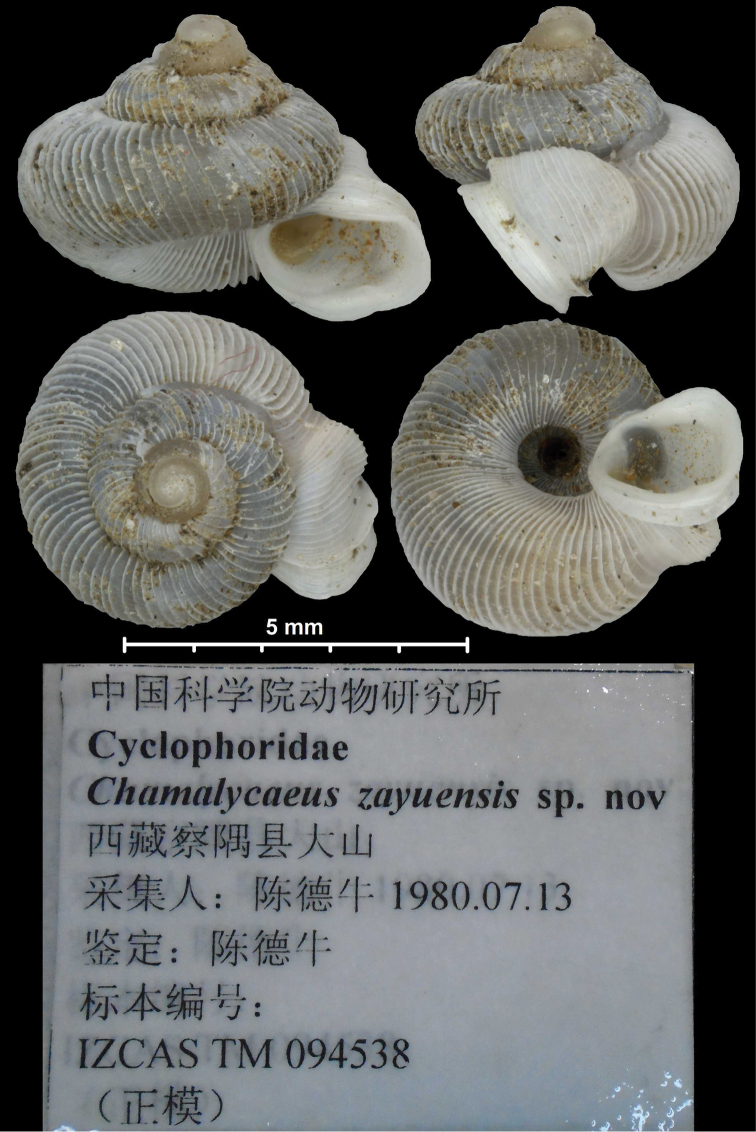
Metalycaeus
zayuensis (Zhang, Chen & Zhou, 2008), holotype (IZCAS TM_094538). Photographs: Kaibaryer Meng.